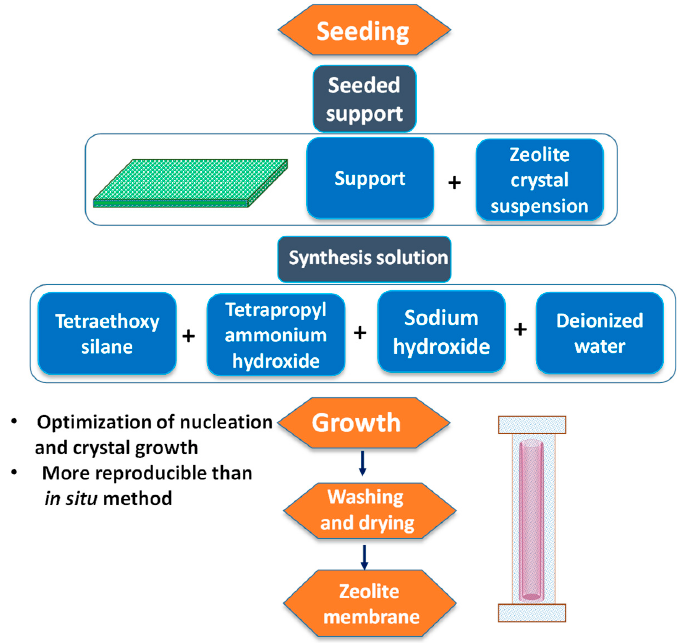
Figure 26. Secondary growth for preparation of the zeolite